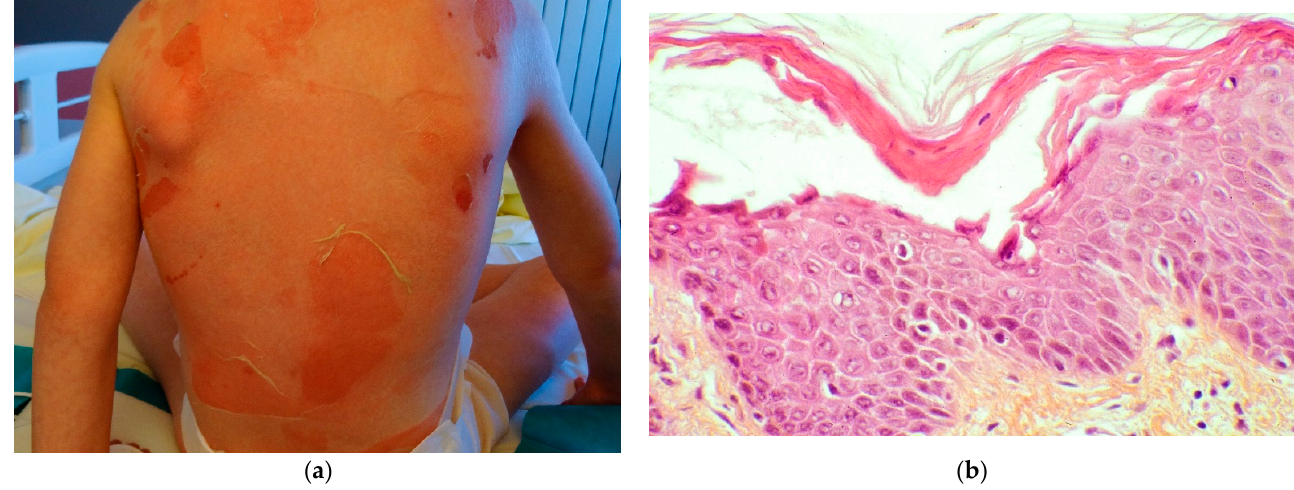
Figure 2. SSSS. ( a ) Clinical appearance of SSSS with Nikolsky sign. ( b ) Hematein eosin ×40: subcorneal blister with acantholysis.